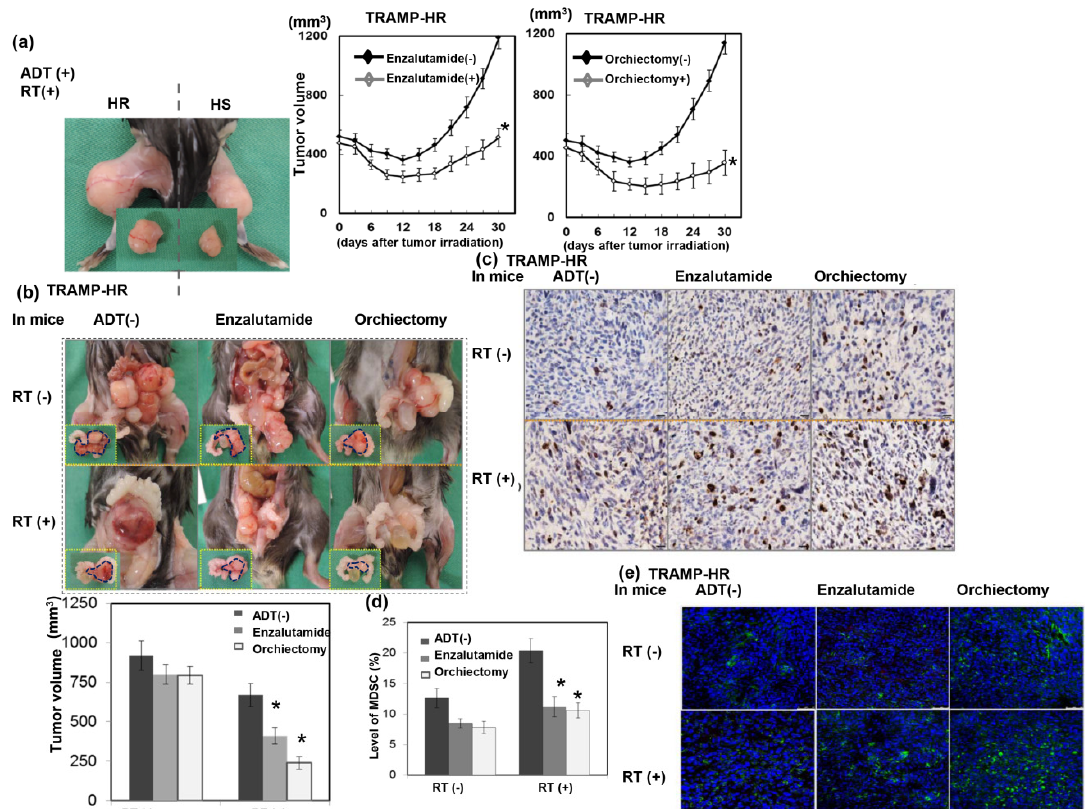
Figure 4. Role of ADT in the radiation sensitivity of CRPC in immunocompetent mice. The role of ADT on the radiosensitivity of CRPC was demonstrated by ( a ) tumor growth delay of TRAMP-HR ectopic tumors after 15 Gy irradiation. We also show the representative images 12 days after 15 Gy irradiation with or without ADT and by ( b ) the orthotopic tumor model 12 days after 15 Gy irradiation in immunocompetent mice. Representative images and quantitative data are shown. The y axis represents the relative ratio, normalized to the tumor size of TRAMP-HR tumors in sham-irradiated male mice (* p < 0.05). ( c ) Expression levels of p-H2AX were evaluated by IHC in CRPC tumors with different types of treatment. Scale bars: 20 µ m. ( d ) The recruitment of MDSCs in the spleen evaluated by FACS using GrI-CD11b staining. The quantification for MDSC levels was the calculation of the value of the number of CD11b+Gr1+ cells divided by the total cell number. Columns: Means of three separate experiments; bars: SD; * p < 0.05. ( e ) The extent of tumor-infiltrating T cells (TILs), shown by immunofluorescence analysis, of tumor specimens using CD3 staining in CRPC tumors with different types of treatment. Scale bars: 50 μ m